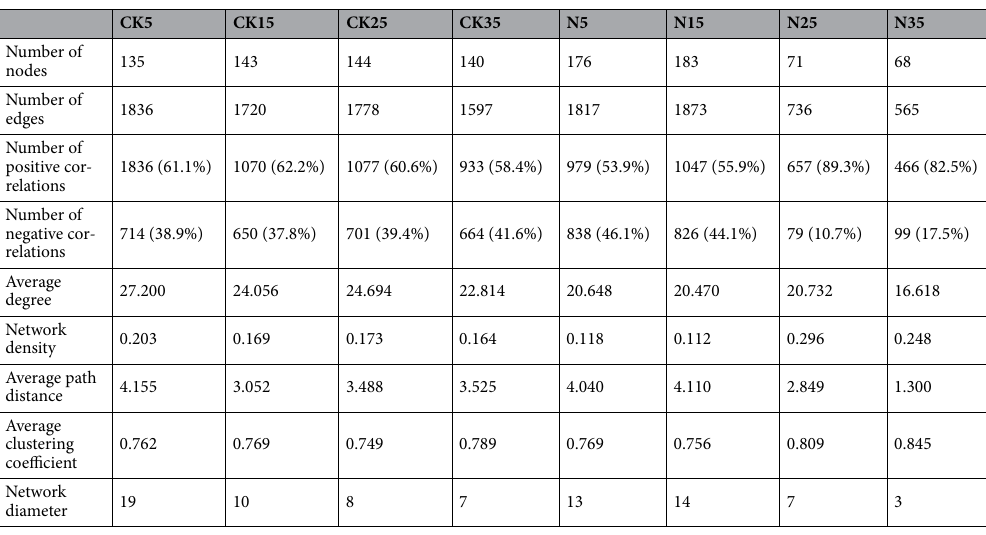
Table 2. Node-level topological features of co-occurrence network at different incubation